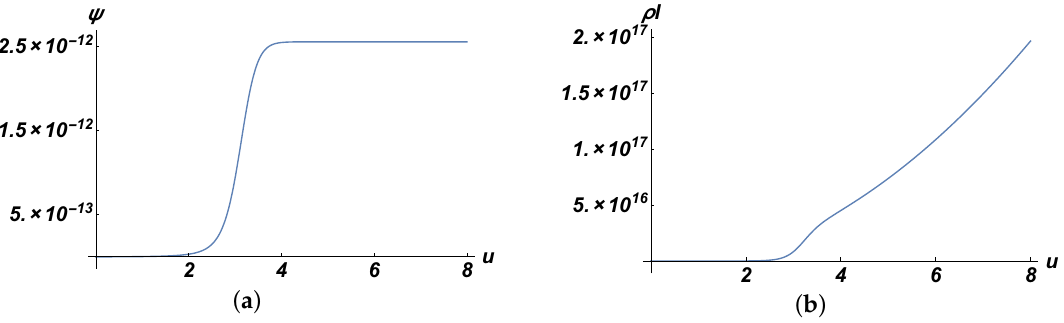
Figure 2. ( a ) represents the behavior of the maximum value of the P , T -odd Faraday angle ψ (in rad) on the dimensionless detuning u for the E1 transition 6 p 2 7 s 21 S 0 → 6 p 2 7 s 7 p 3 P 1 in Ra atom, ( b ) represents the behavior of the column density ρ l (in cm − 2 ) on the dimensionless detuning u for the E1 transition 6 p 2 7 s 21 S 0 → 6 p 2 7 s 7 p 3 P 1 in Ra